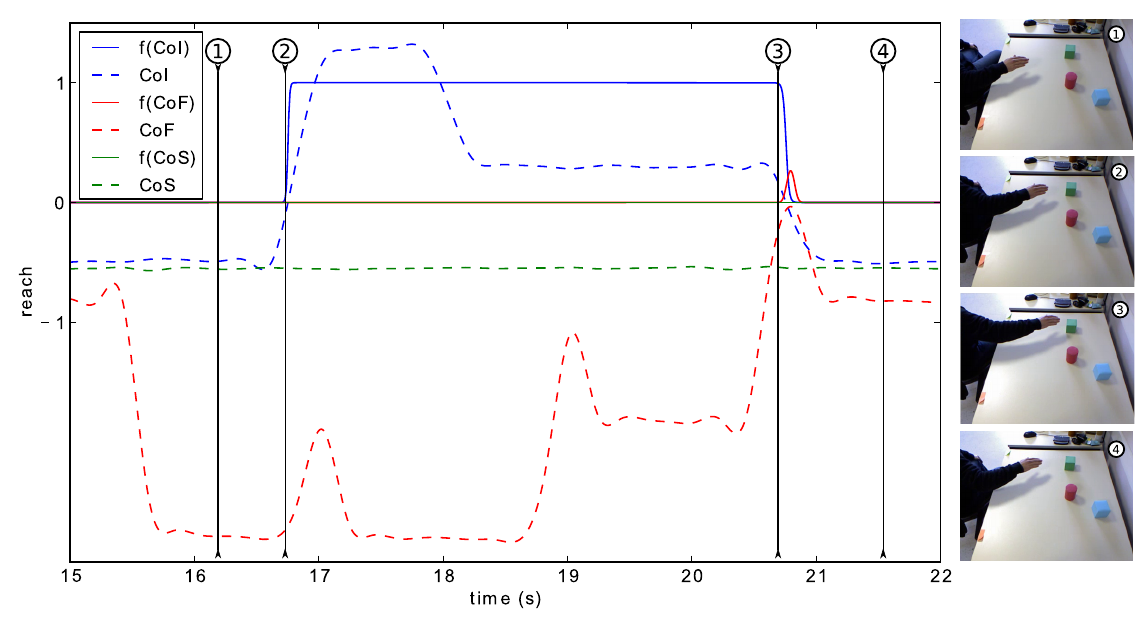
Figure 9: Detection of a failed reaching action: condition of failure